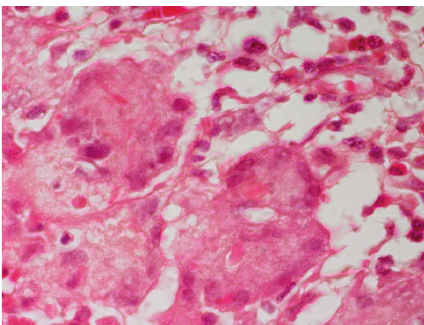
Figure 6: Even a higher magnification of the previous area shows foreign body of giant cells and chronic inflammatory cells. H&E × 400.